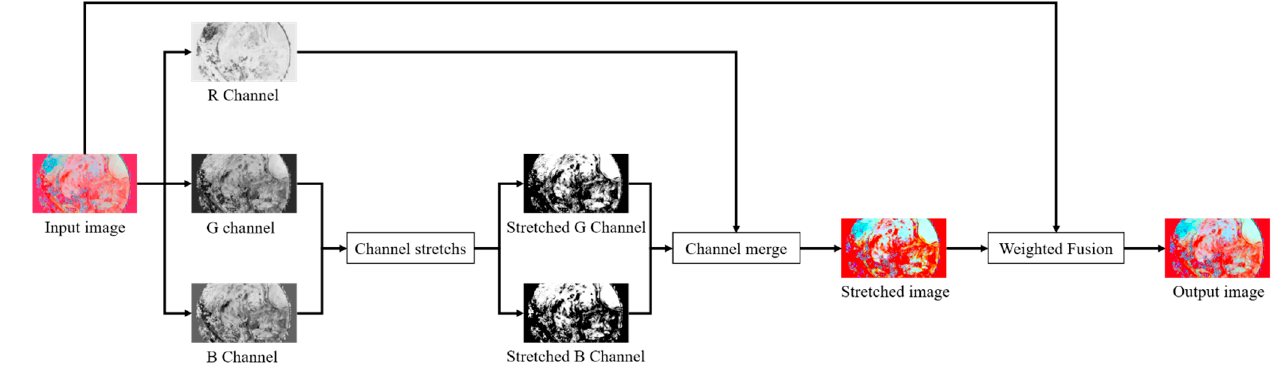
Figure 5. Designed method of reflective component correction.